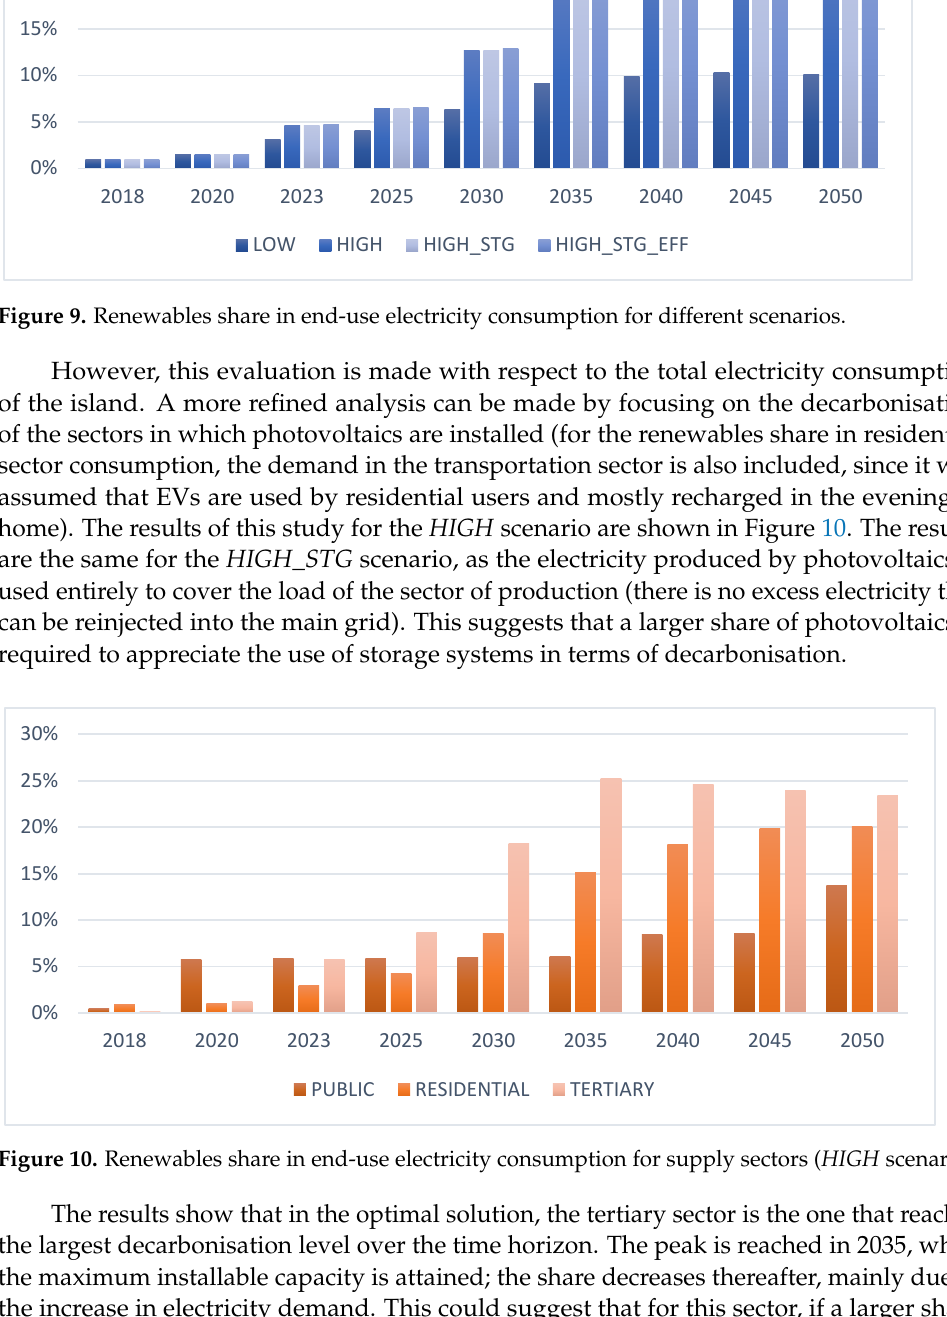
15 of 27 Table 3. Summary of the scenarios considered for analysis. Scenario